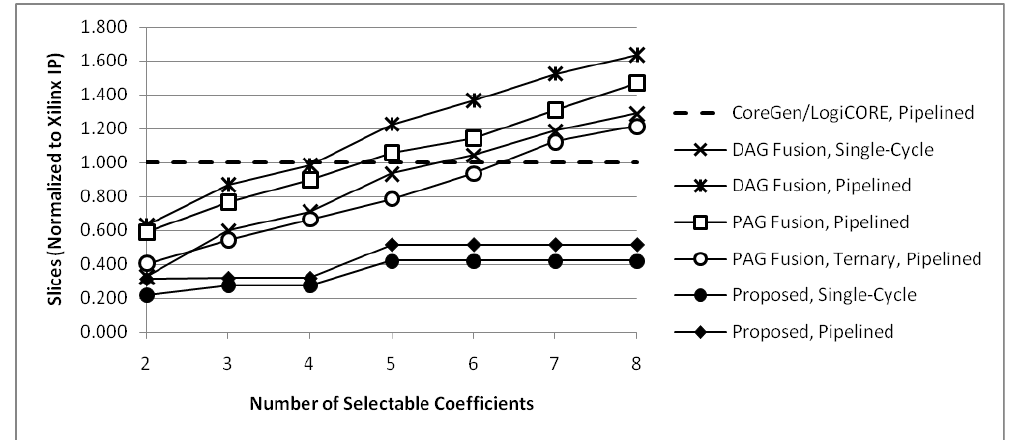
Figure 16. Slice utilization for directed acyclic graph (DAG) fusion [11,13], pipelined adder graph (PAG) fusion [13] and proposed (16 × 16)-bit KCMs with two to eight selectable coefficients. One slice contains four LUT6s and eight flip-flops (see Figure 1). DAG fusion and PAG fusion units are normalized to CoreGen as presented in Möller et al. [13], proposed units are normalized to a LogiCORE IP multiplier-based